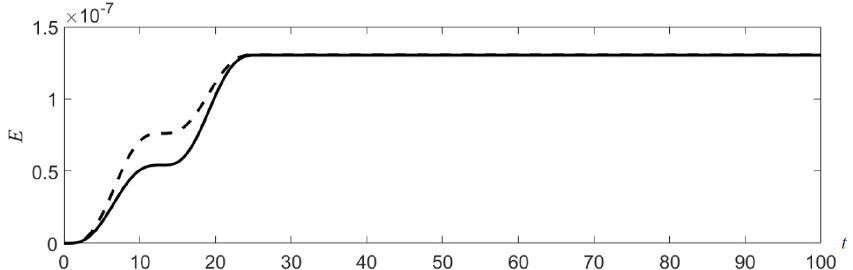
Figure 4. Integral total energy in the discrete chain with respect to time: for compression–tension (the solid line) and tension–compression (the dashed line) harmonic impulses.